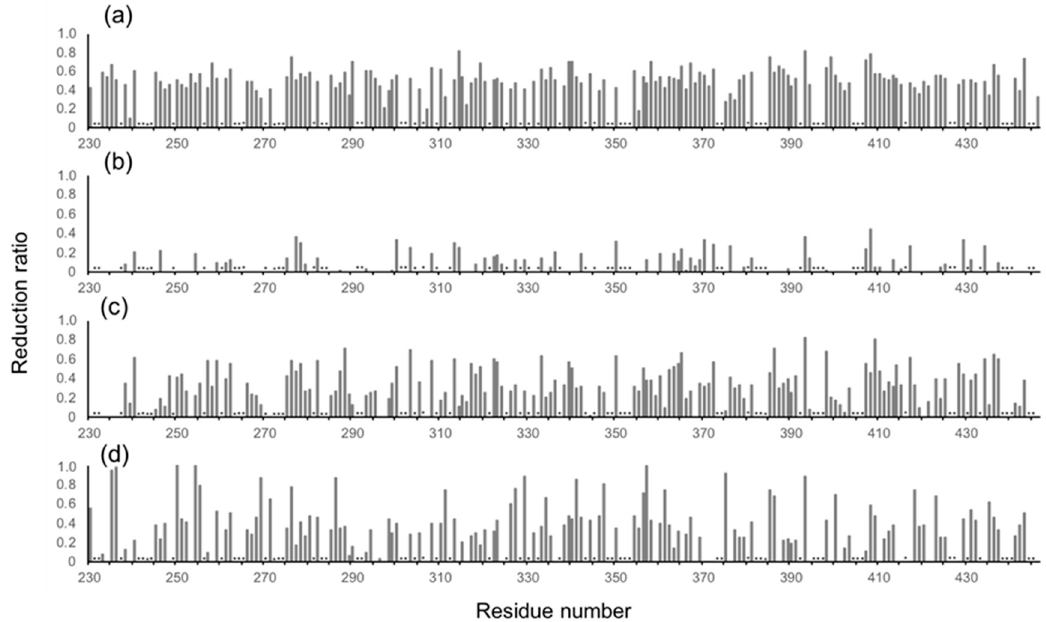
Figure 3. Profiles of the observed spectral perturbations by ( a ) human serum, ( b ) HSA, ( c ) human polyclonal IgG, and ( d ) the Fab fragment derived from human serum polyclonal IgG. The attenuation in intensity (( I o − I p)/ I o, where I o and I p are original peak intensity and intensity after perturbation, respectively) of the HSQC cross peaks is plotted across the amino acid sequence of mouse IgG-Fc. Asterisks indicate proline residues, unassigned residues and residues whose peak intensity data could not be obtained due to severe peak overlapping.